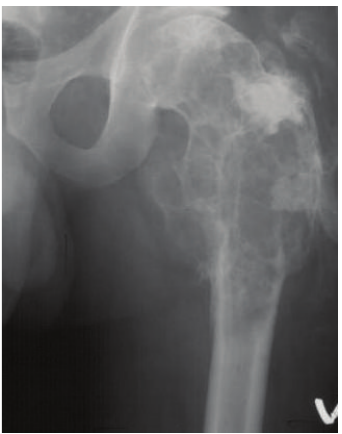
Figure 1: Radiograph from the original tumour.